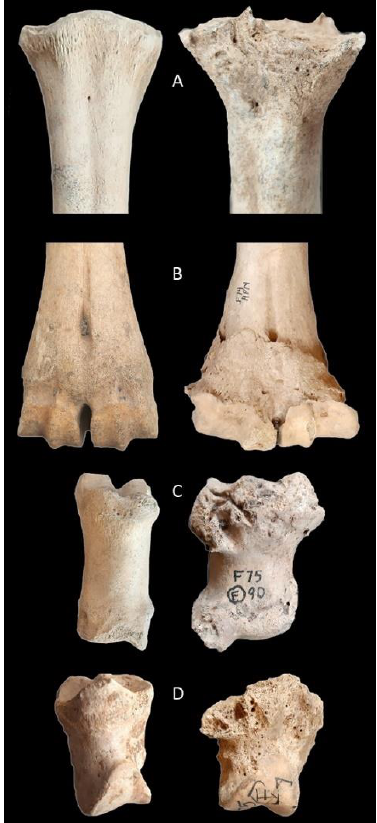
Figure 2. Selected cattle foot bones (anterior view) illustrating examples of severe changes. ‘Normal’ examples are shown on the left and lesions on the right: ( A ) proximal metatarsal illustrating stage 3 lipping and exostosis; ( B ) cattle metacarpal, showing stage 4 exostosis and broadening; ( C ) first phalanx showing stage 4 proximal and distal exostoses; and ( D ) second phalanx illustrating stage 4 proximal lipping and exostosis.